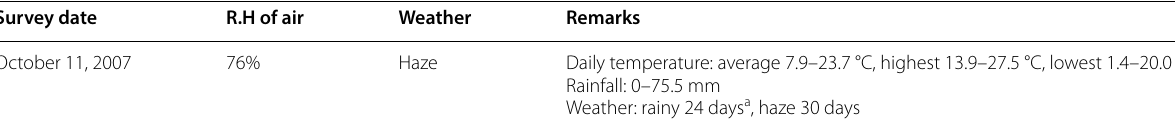
Table 4 Weather condition of the location of the pilot bridge for 30 days.